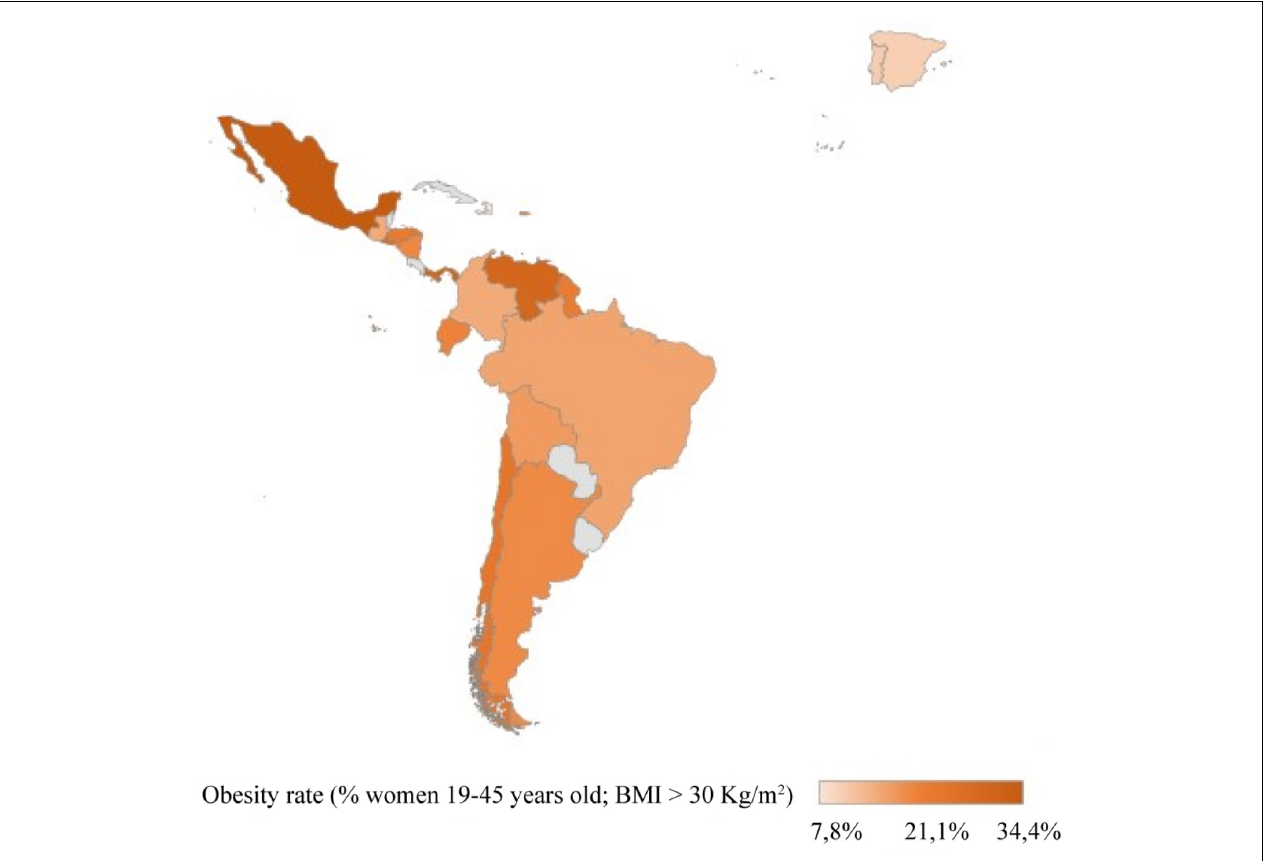
FIGURE 1 | Estimates of obesity in women of childbearing age in Latin-America. Percentage of obesity (BMI ≥ 30 Kg/m 2 ) in women between 18 and 45 years old. BOL, BRA, COL, ECU, ESV, GUA, HAI, HON, MEX, NIC, PER, and GUY obesity prevalence obtained from National Health Surveys and compilated in (Correa and Marcinkevage, 2013). VEN prevalence obtained from Instituto Nacional de Nutrición (2008–2010). CHI obesity prevalence obtained from Encuesta Nacional de Salud (ENS-2009) and reviewed in (Araya et al., 2014). PAN obesity prevalence obtained from cross-sectional studies (2010–2011) (Mc Donald et al., 2015). ARG obesity prevalence obtained from Encuesta Nacional de Nutrición y Salud (ENNyS-2007). PR obesity prevalence obtained from self-reported, prospective longitudinal cohort study (2011–2014) (Guilloty et al., 2015). SPA and POR obesity prevalence obtained from the European Health Interview Survey (EHIS